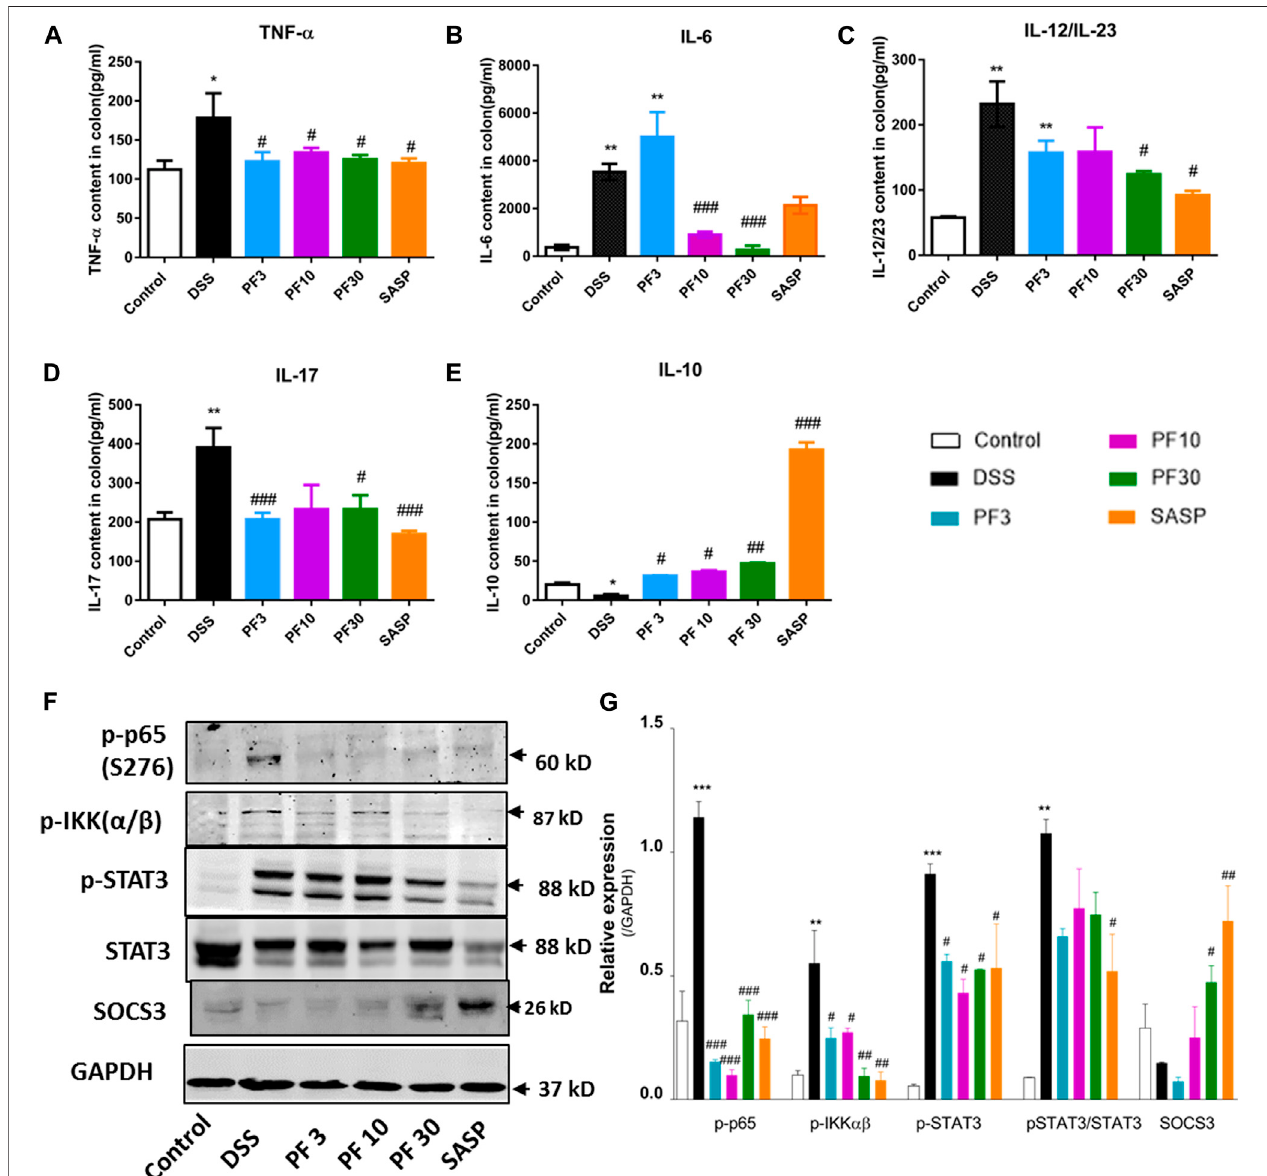
FIGURE 3 | PF-04447943 prohibited in fl ammation regulating cytokines secretion and suppressing p65, STAT3 activation in DSS-induced colitis mice. (A) TNF- α (B) IL-6 (C) IL-12/IL-23 (D) IL-17 (E) IL-10 content in colon homogenate were quanti fi ed by ELISA assay. (F) Expression of p-p65 (S276), p -IKK α / β , p-STAT3 (Y705), STAT3, and SOCS3 in colon determined by western blot analysis. (G) Relative protein expression of p-p65, p-IKK α / β , p-STAT3, and SOCS3, successively. Data are presented as mean ± standard error mean (SEM)( n (cid:1) 2 – 5). Here, *** p < 0.001, ** p < 0.01, * p < 0.05 vs. control group and ### p < 0.001, ## p < 0.01, # p < 0.05 vs. DSS-treated